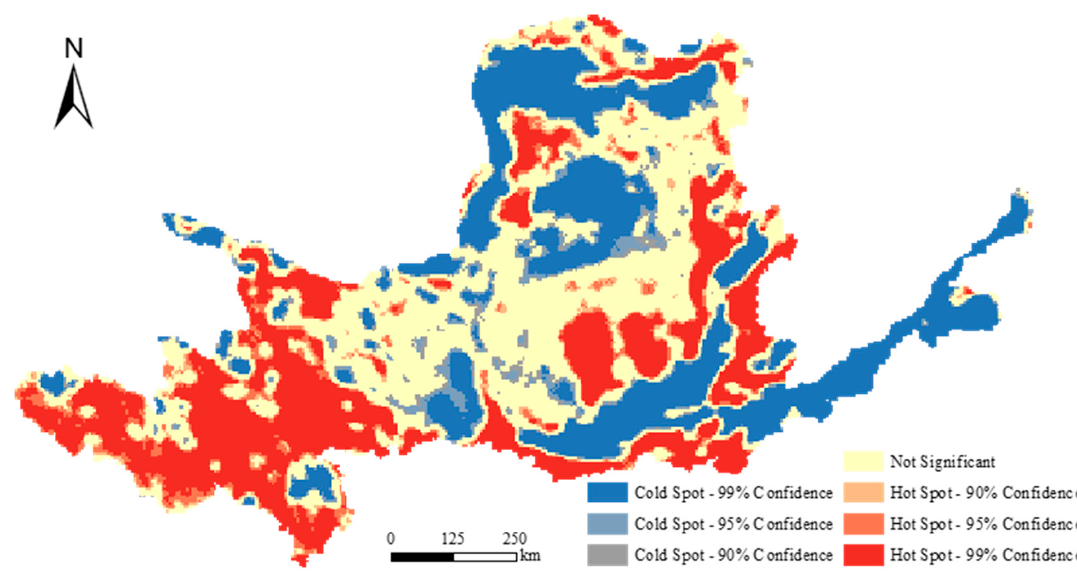
Figure 11. Habitat quality “Cold and hot spot” analysis in the Yellow River Basin in 2020.